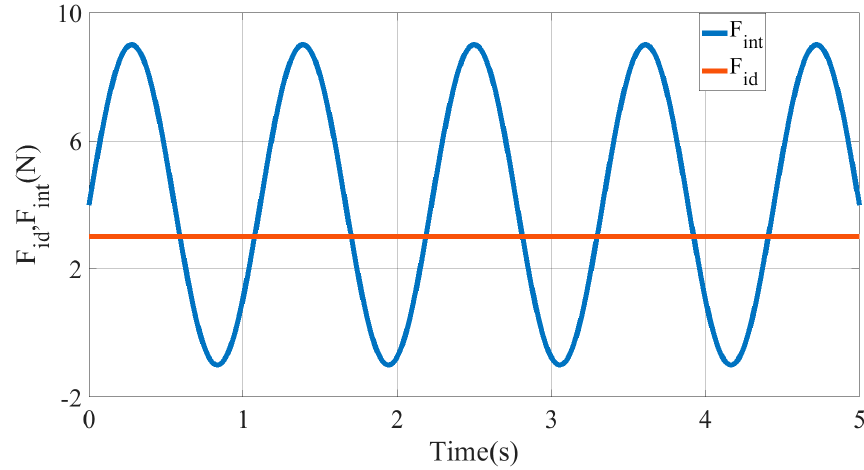
Figure 14. The curve of ISBF F id and human-machine interaction force F int .